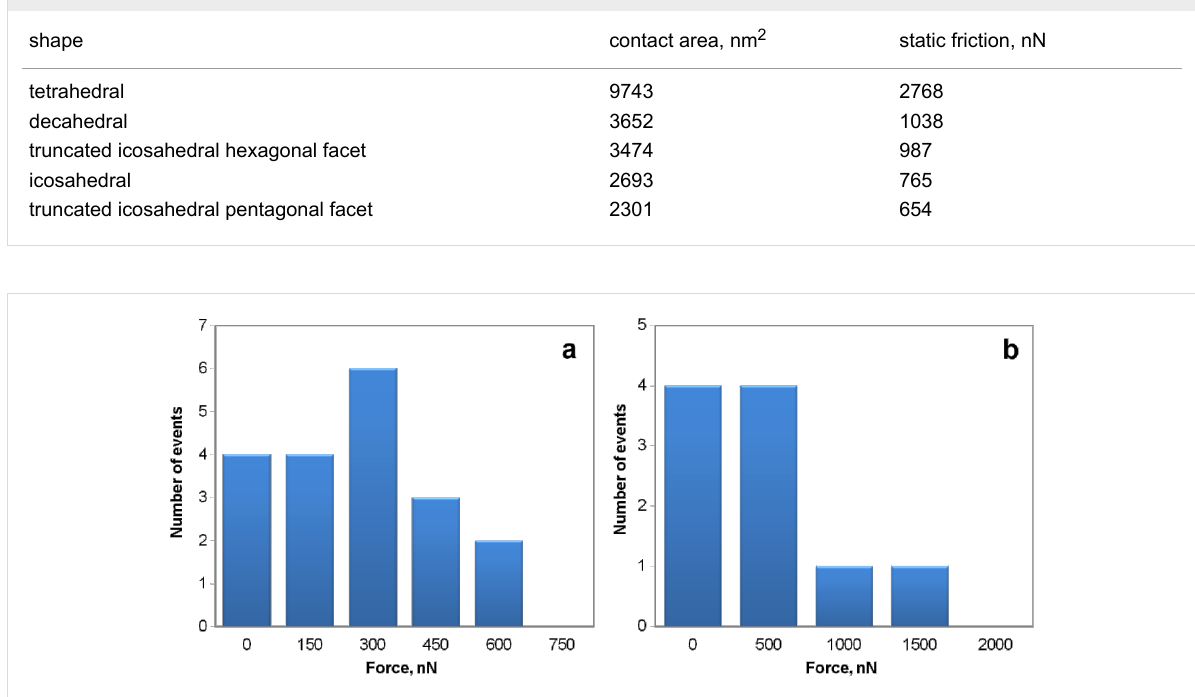
Figure 7: Distribution histogram of static friction force values that were experimentally measured for NPs of different shapes: polyhedron-like Au NPs (a) and for sphere-like Ag NPs (b), respectively.